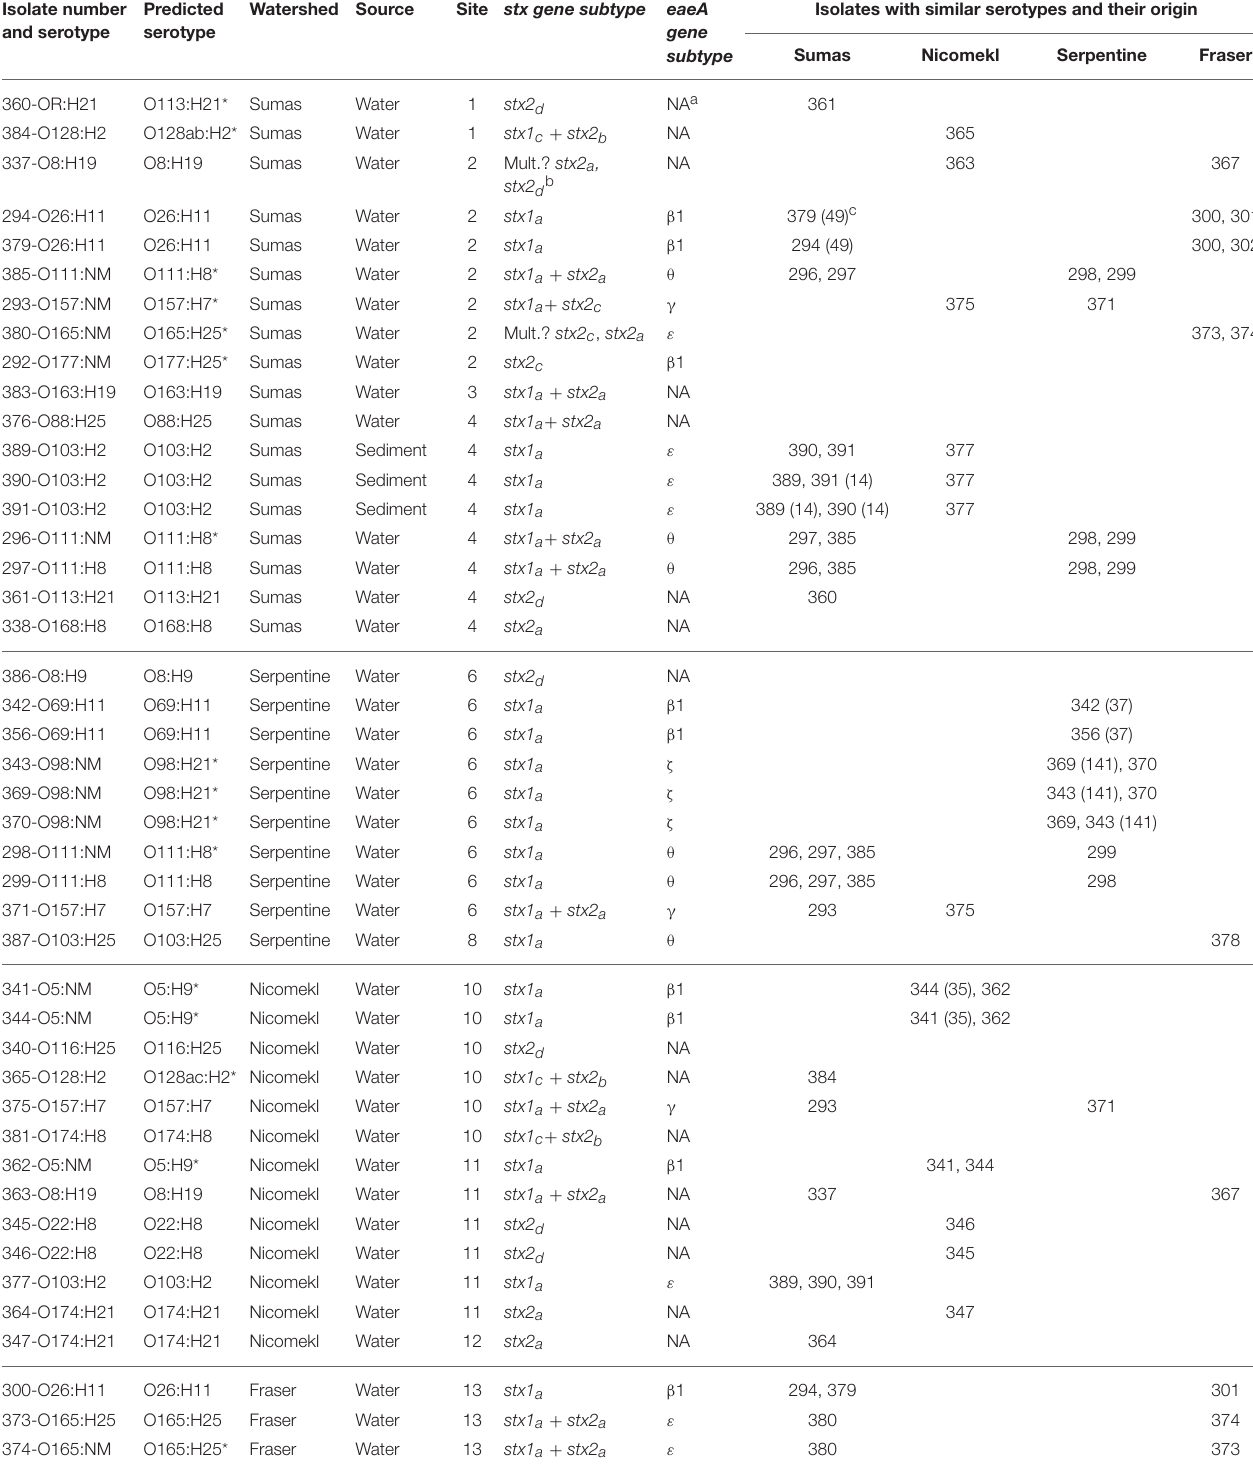
TABLE 5 | Predicted serotypes, stx and eaeA gene subtypes derived from whole genome sequence analysis of 47 STEC isolates recovered from surface waters and sediments in different sampling sites within four watersheds of the Lower Mainland of British Columbia. Isolates with similar serotypes and their origin are also